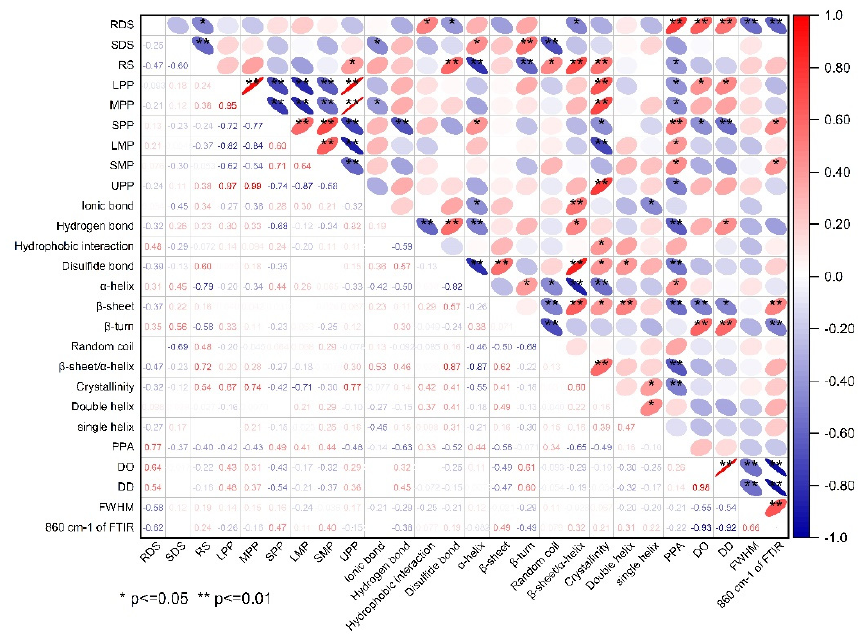
Figure 6. The correlation between starch digestiblity and structural characteristics of protein and starch. The red and blue ellipses indicated positive and negative correlations, respectively, and the degree of correlation was increased with decreased area and increased color depth of the ellipses. The red-blue ruler on the right of the correlation matrix illustrated the correspondense between color and correlation coefficient.